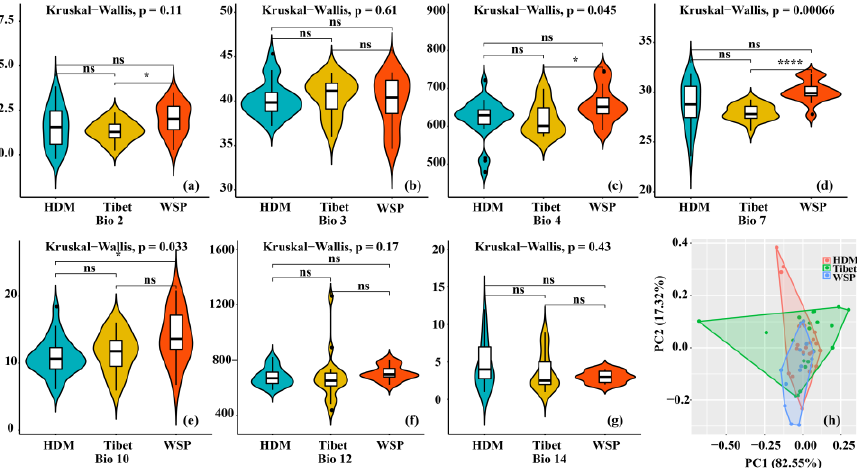
Figure 4. Nonparametric Kruskal–Wallis multiple-range tests ( a – g ) and the PCA ( h ) based on climatic data extracted from the 58 occurrences of three lineages belonging to Quercus aquifolioides .